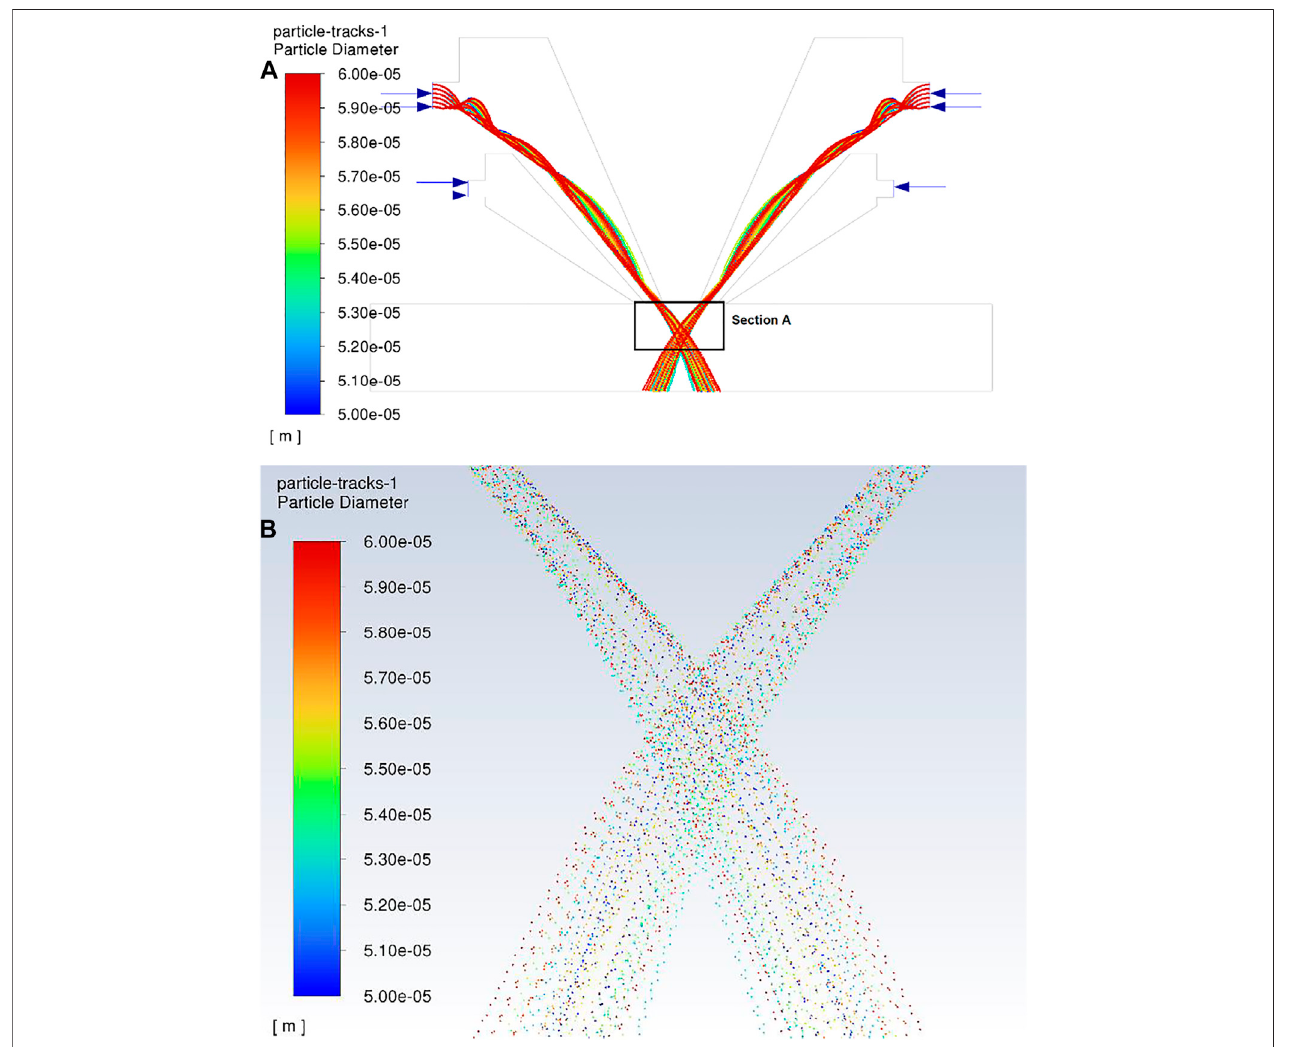
FIGURE 10 | (A) Powder particle track simulation. (B) Section A of the particle track simulation.